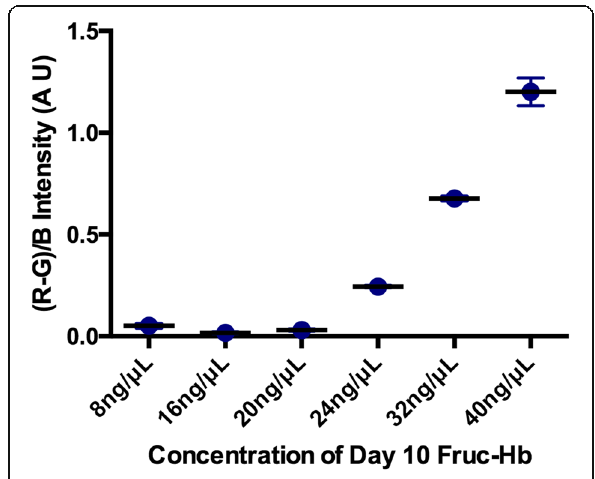
Fig. 6 Linearity of detection. The red colour intensity as quantified by (R-G)/B intensity of GNP colloids plotted against the concentration of day 10 Fruc-Hb used for the synthesis. The concentration was varied from 8 to 40 ng/ μ